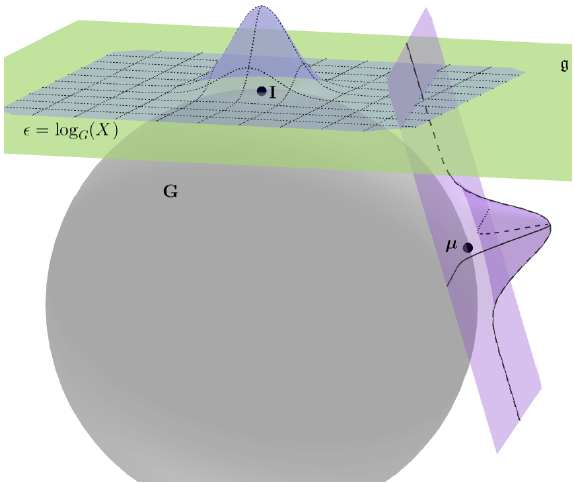
Figure 2: The Gaussian distribution of X on the mean el- ement µ is obtained by transporting the approx- imated Gaussian distribution at the identity of G to the mean state µ